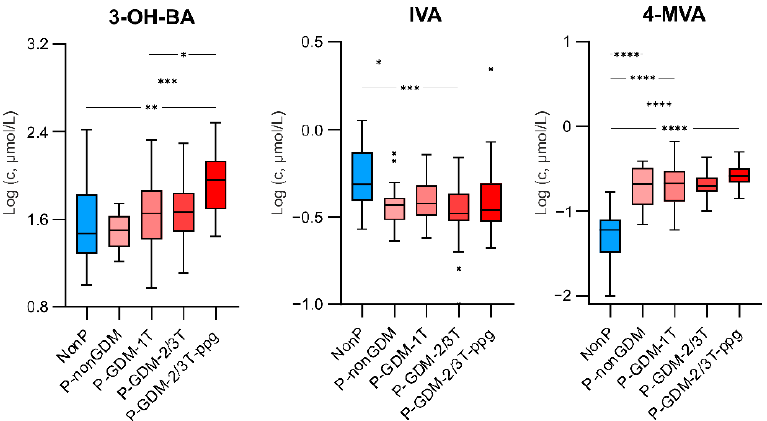
Figure 1. Distribution of derivatives of SCFA for all groups of non-pregnant (blue) and pregnant (red) women with statistical significance (* p < 0.05, ** p < 0.01, *** p < 0.001, **** p < 0.0001).